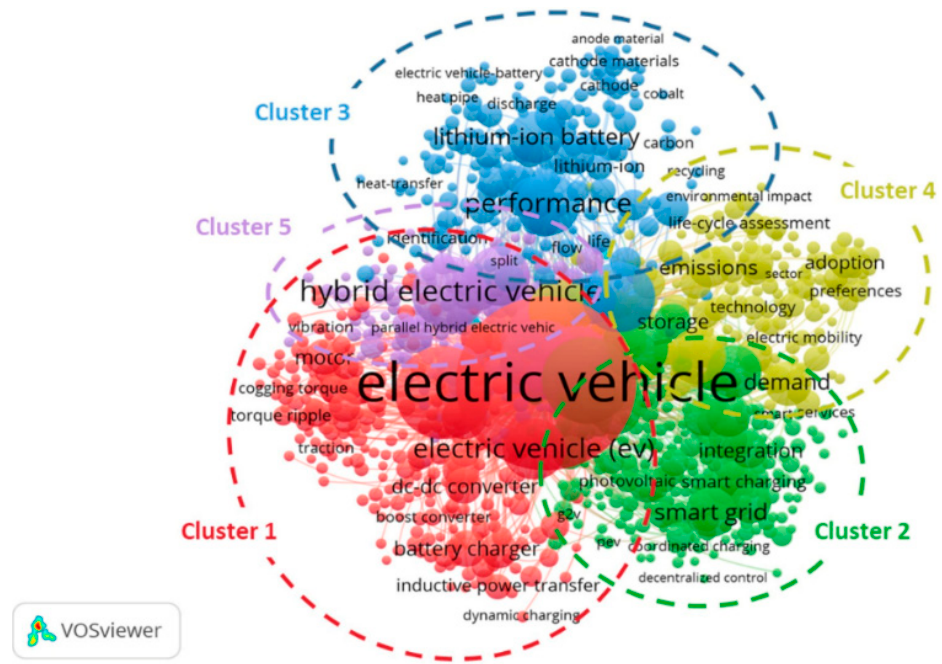
Figure 7. Network visualization of the keywords based on total link strength.